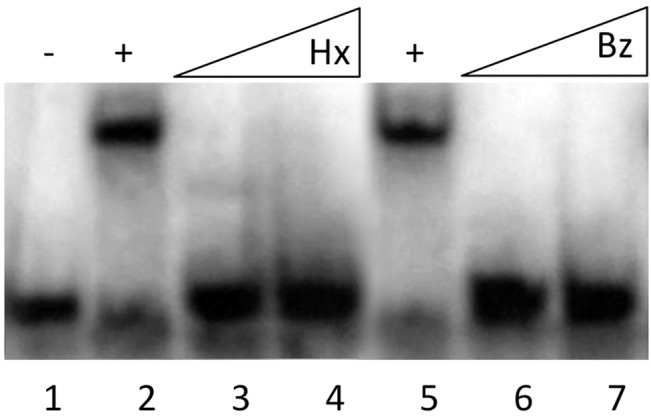
Effect of hexachlorophene and benzalkonium chloride on the capability of SmeT to bind its operator DNA.A γ-[32P] labeled double stranded DNA fragment containing the SmeT operator site (lane 1) was incubated with SmeT (0.2 μM) for 20 min at room temperature (lane 2). Subsequently, increasing concentrations of benzalkonium chloride (Bz) or hexachlorophene (Hx) were added (0.1 mM and 0.2 mM of each). As shown both biocides break the SmeT-DNA complex.